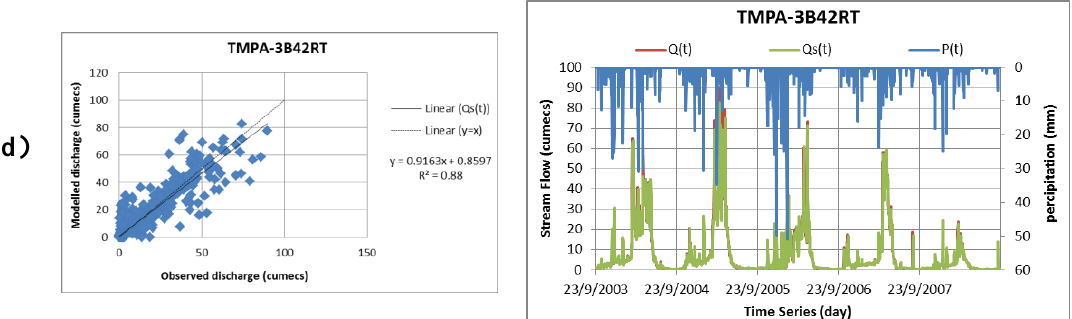
Figure 5. The scatter plots of modeled against observed discharges for a) CMORPH, b) PERSIANN, c) TMPA-3B42, and d) TMPA-3B42RT